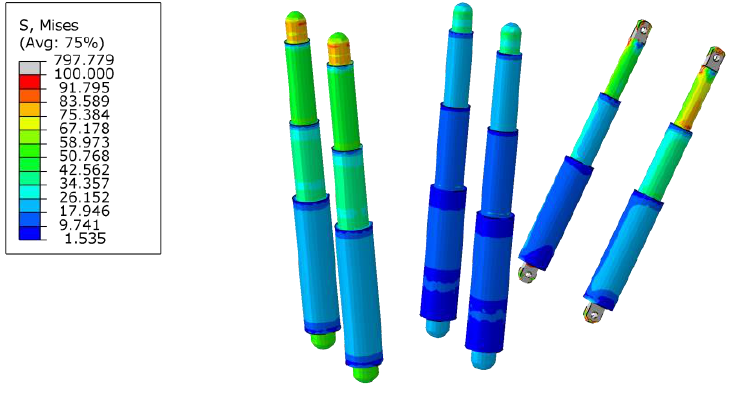
Figure 11. Stress of columns.